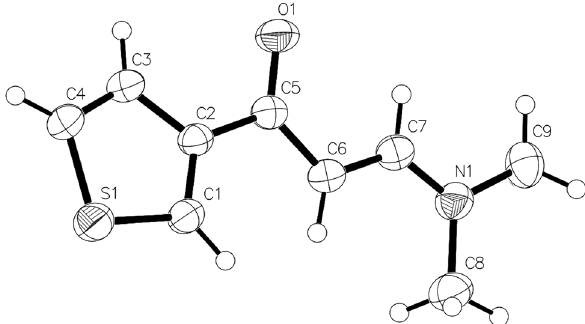
Table  : Data collection and handling.